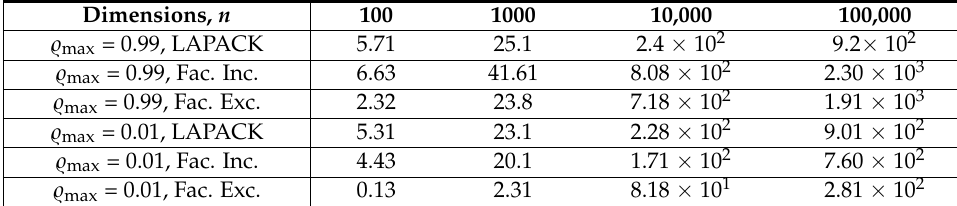
Table 2. Run-times (in seconds) for solving V using the Gauss–Seidel algorithms. Dimensions,